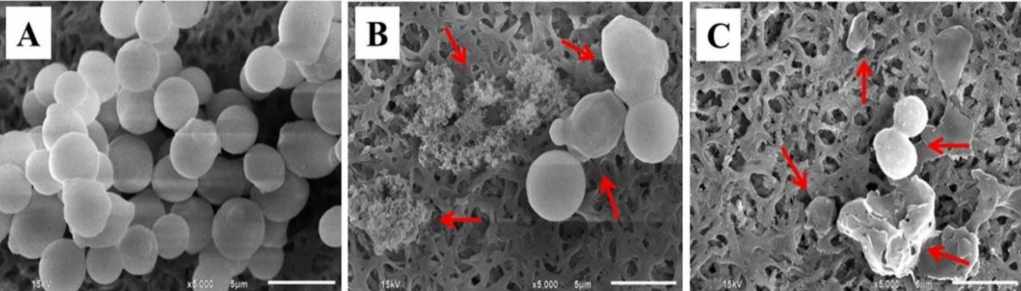
Figure 7. SEM micrographs of C. albicans cells. Untreated cells ( A ), cells treated with APC-SNEDDS ( B ), and cells treated with nystatin ( C ) (5000 × ). Arrows indicate the irreversible morphological destruction of the treated C. albicans cells.